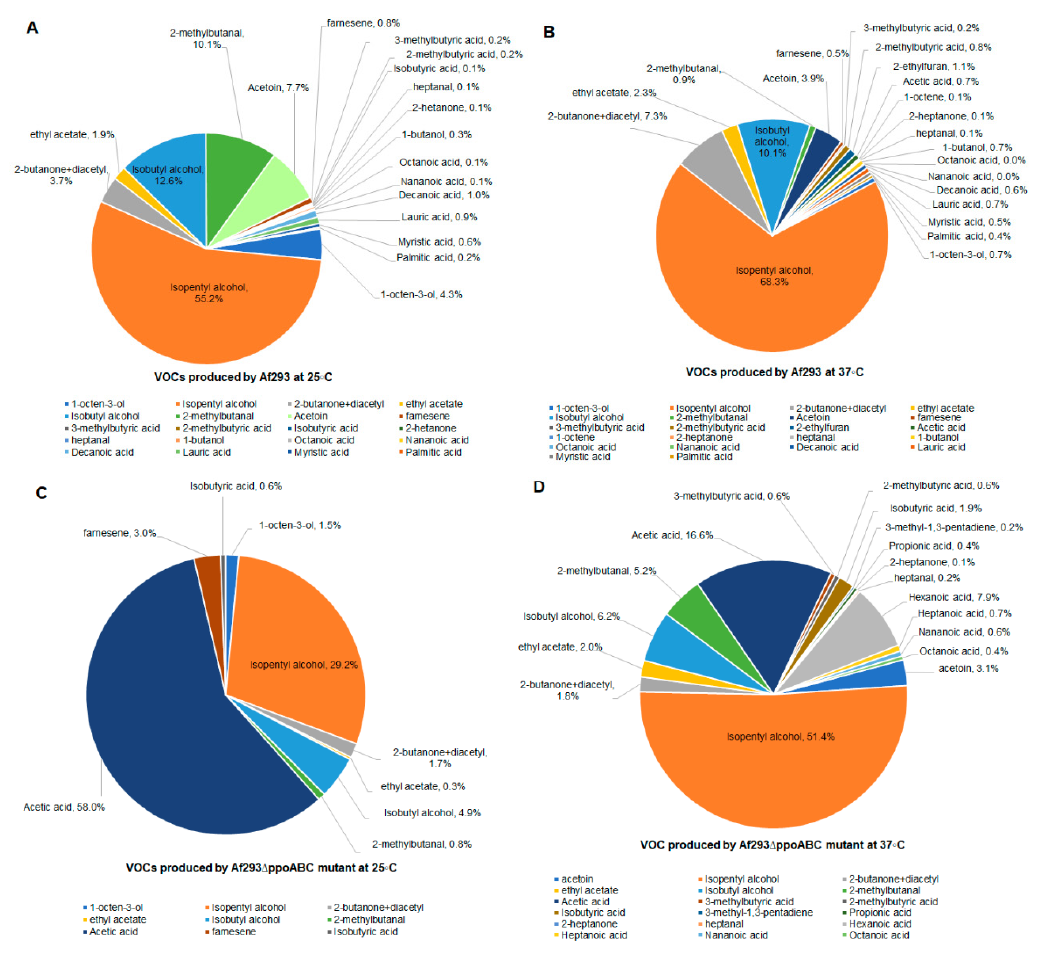
Figure 6. VOCs profiles produced by Af293 and Af293 ∆ ppoABC strains. VOCs produced by Af293 pre − grown at 25 °C for 5 days are shown in ( A ); VOCs produced by Af293 pre − grown at 37 °C for 3 days are shown in ( B ); VOCs produced by Af293 ∆ ppoABC pre − grown at 25 °C for 5 days are shown in ( C ); and VOCs produced by Af293 ∆ ppoABC pre-grown at 37°C for 3 days are shown in ( D ).